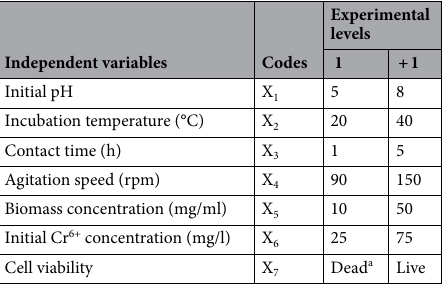
Table 5. Independent variables for the evaluation of Cr 6+ biosorption by the selected Actinomycete isolate using Plackett–Burman design. Where; 1 = low level; + 1 = high level. a Dead cells where the biomass was killed by autoclaving at 121ºC for 20 min.